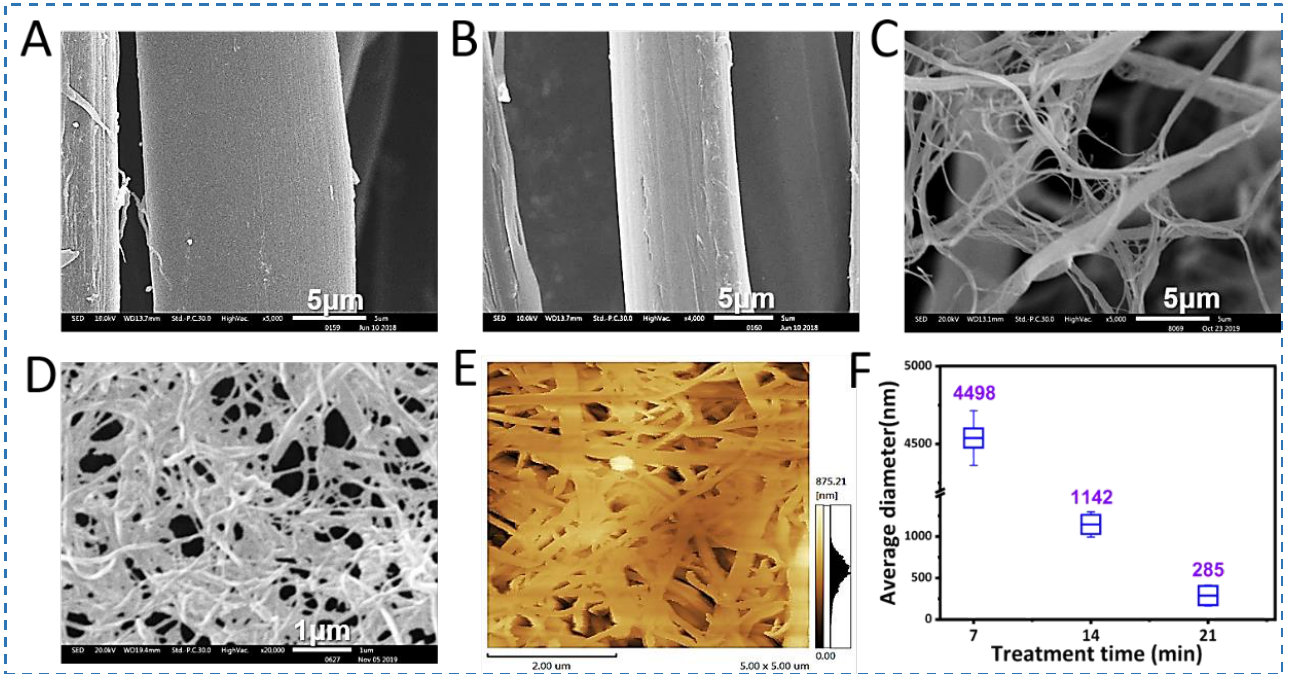
Figure 2. The morphology and diameters of SNFs and SNF films. ( A – D ) represent SEM images of SNFs film with different magnifications, ( E ) represents AFM images of SNFs film, and ( F ) the average diameters of the SNFs treated with different treatment times. Scale bars for ( A – E ) are 5 µ m, 5 µ m, 5 µ m, 1 µ m, and 2 µ m, respectively.